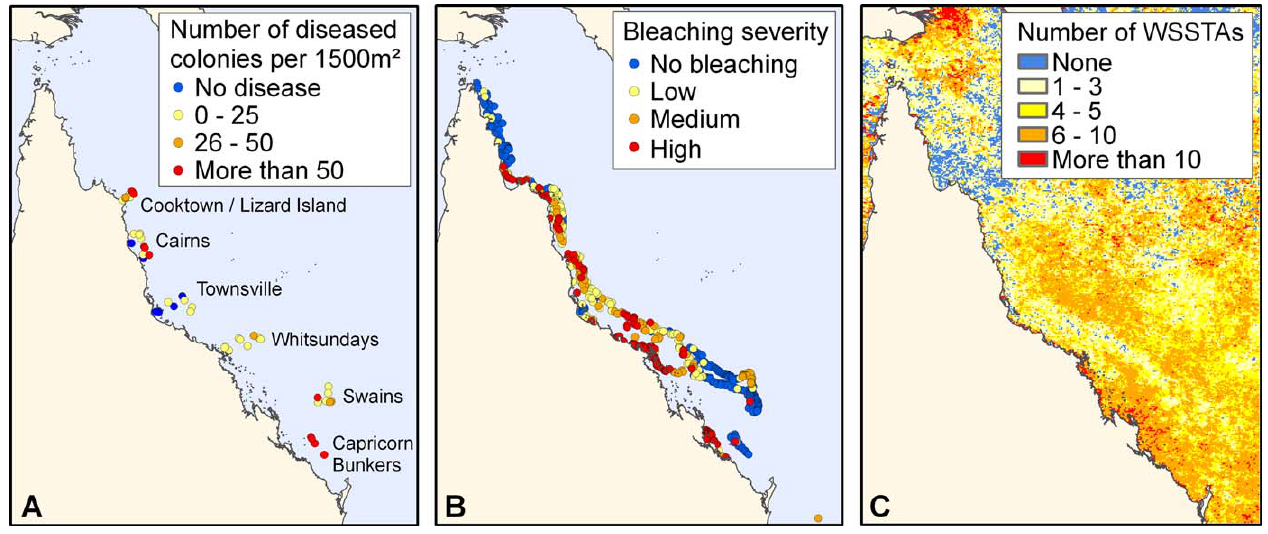
Figure 1. Study Sites and Disease Conditions during the Peak of White Syndrome Frequency in 2002 (A) Frequency of white syndrome cases from March 2002 to March 2003; (B) bleaching intensity for scleractinian coral in March 2002 (modified from Berkelmans et al., 2004 [73]); and (C) WSSTAs in 2002.